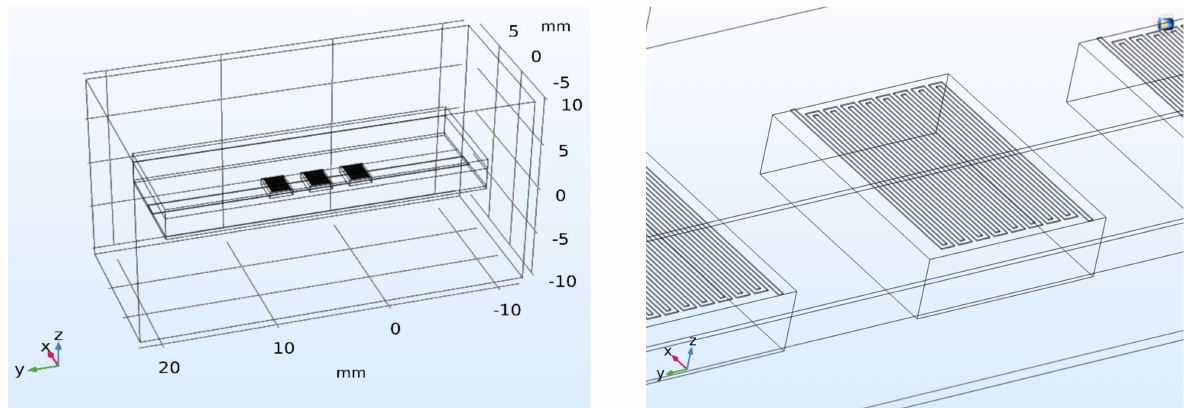
Figure 2. A geometry of the analyzed structure in the simulation environment and ( left ) a detail of simulated RTD Pt100 elements with integrated platinum meander structure ( right